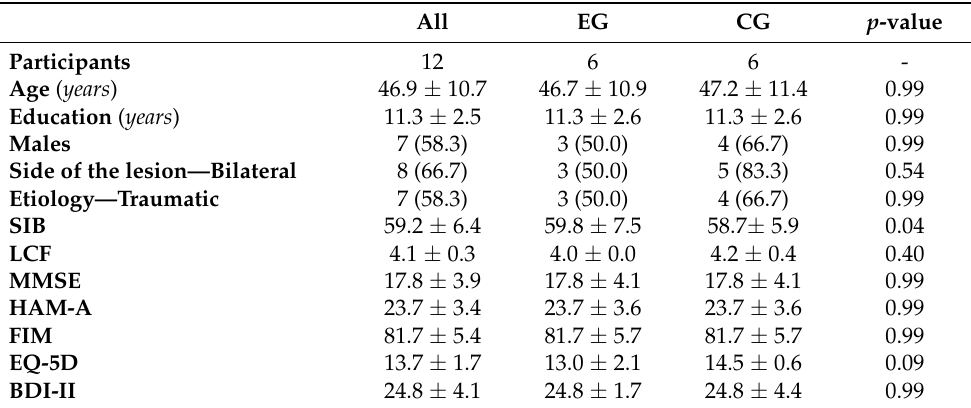
Table 1. Descriptive analysis of the sample’s characteristics at